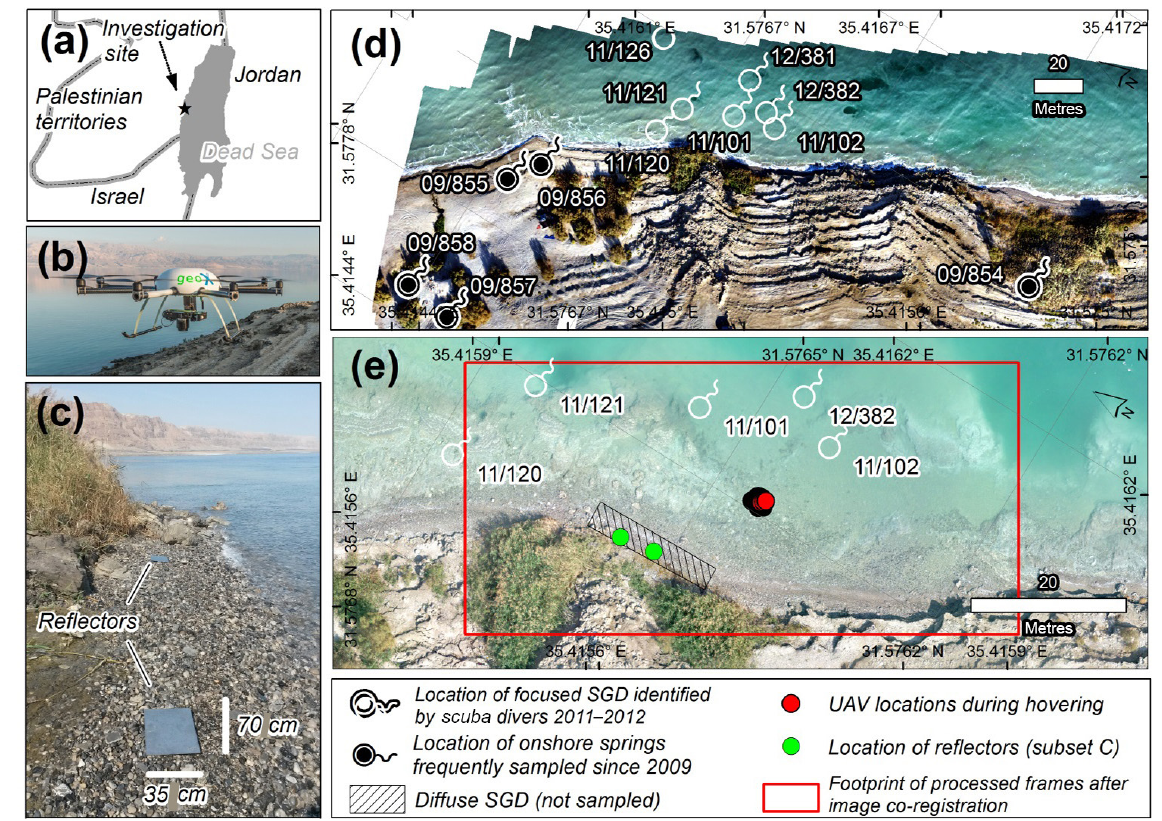
Figure 1. Location of the study area at the Dead Sea (a) , photo of the UAV used during the study (b) , photo of both reflectors at the covered coastline section (c) , distribution of focused SGD spots identified and sampled by divers in the years 2011 and 2012, and onshore springs which have been sampled frequently since 2009 (d) , and an aerial photograph from 10 February 2016 at 12:11LT of the covered area along with UAV positions during hovering, location of reflectors, the footprint of the processed frames after co-registration described in Sect. 2.3 and locations of observed diffuse SGD (e)